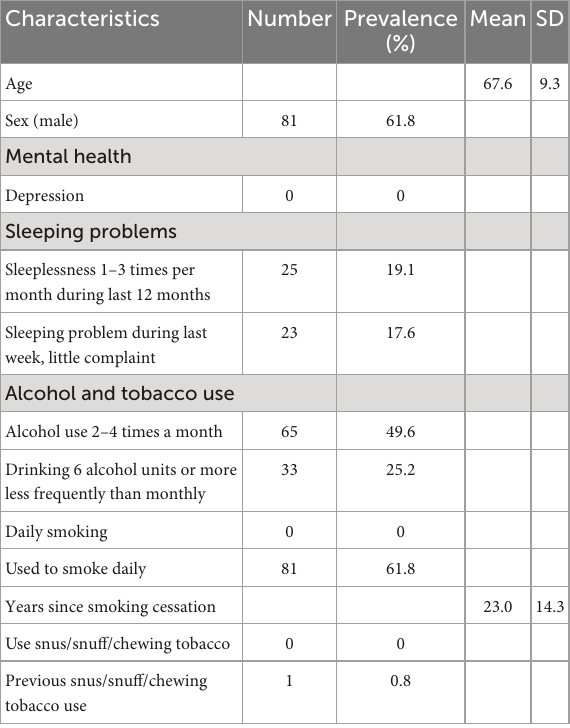
TABLE 1 Study sample characteristics ( N =